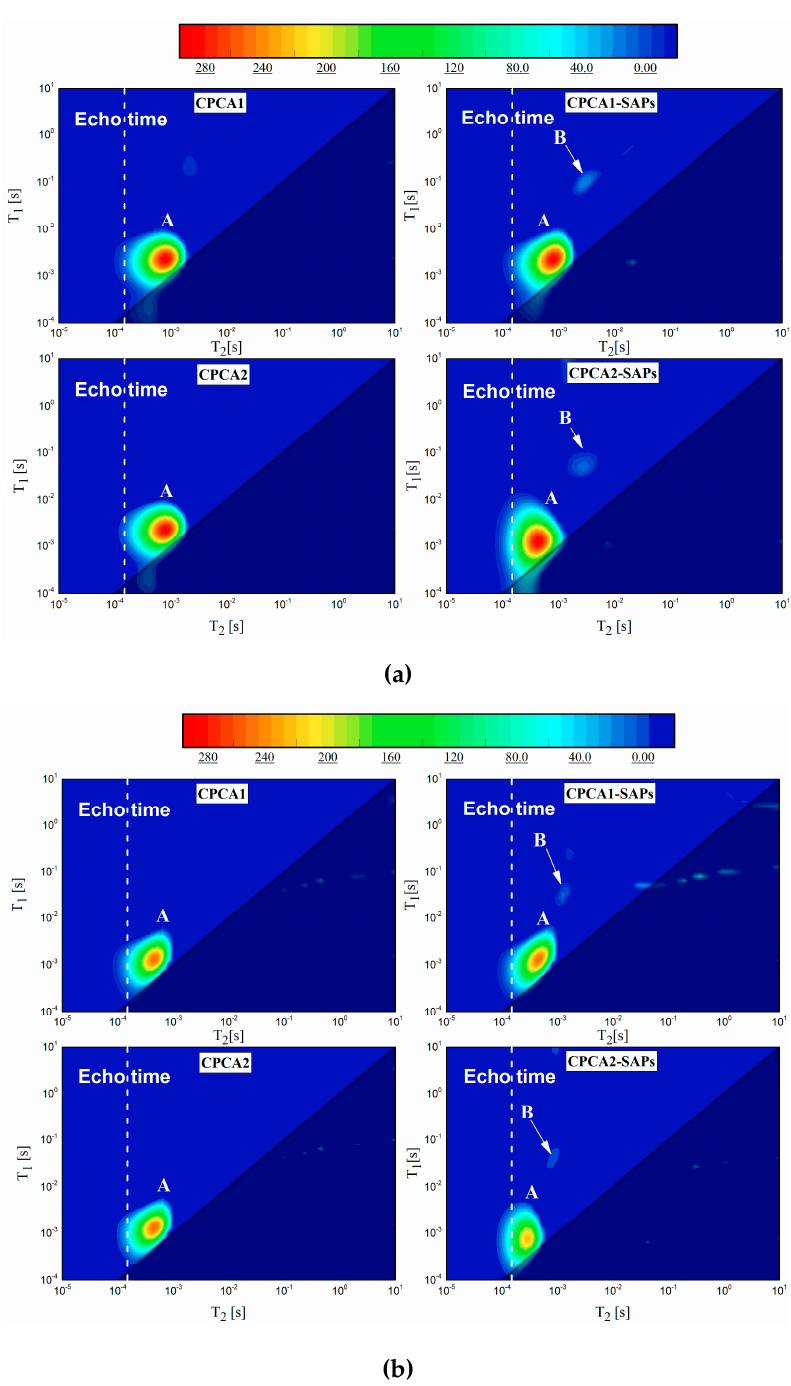
Figure 7. T 1 - T 2 maps of the cement paste containing accelerator sample with or without SAPs at ( a ) 7 and ( b ) 28 days (The line indicates T 1 / T 2 = 1 and the vertical dashed line shows the minimum echo time of the instrument).